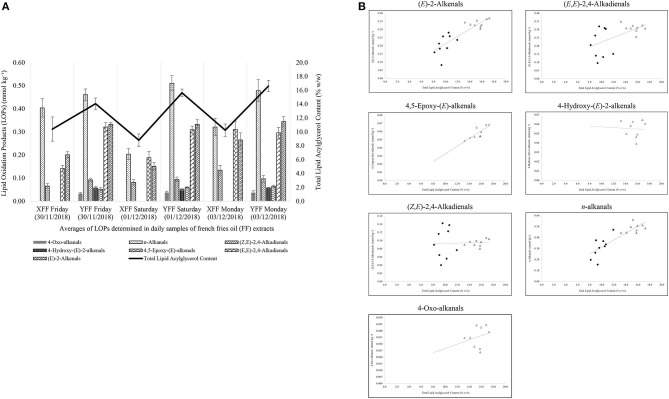
(A) Secondary aldehydic LOPs concentrations of FF samples collected from restaurants X and Y on consecutive weekly days (Friday, Saturday, and Sunday), and their total lipid contents. These data reveal a significant correlation between aldehyde and total lipid levels. All values are presented as mean ± SD values. (B) Relationships between mean FF concentrations of aldehydic LOPs and total lipid contents of FF samples for restaurants X (filled spheres) and Y (unfilled triangles).